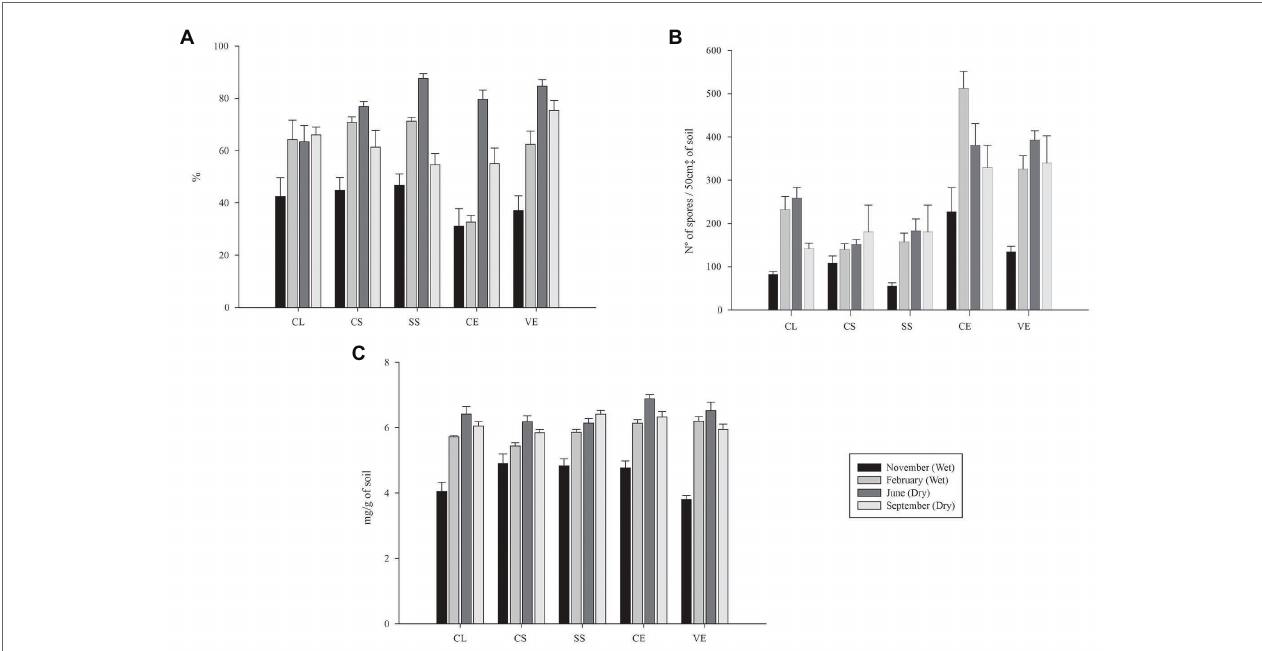
FIGURE 3 | Mycorrhizal colonization rate (A) , spore density (B) , and glomalin easily extractable (C) from soils from the Cerrado during the rainy (first and fourth) and dry seasons (second and thirrd). CL, Campo Limpo; CS, Campo Sujo; SS, Strictu Sensu; CE, Cerradão; and VE,